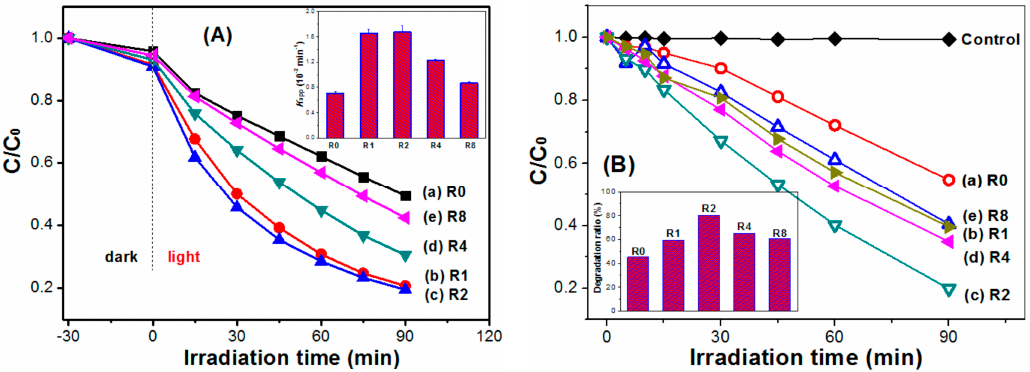
Figure 8. Photocatalytic degradation profiles of X3B ( A ) and RhB ( B ) under visible-light irradiation in the presence of different TiO 2 nanorods photocatalyst (inset: comparison of the corresponding photocatalytic activity).